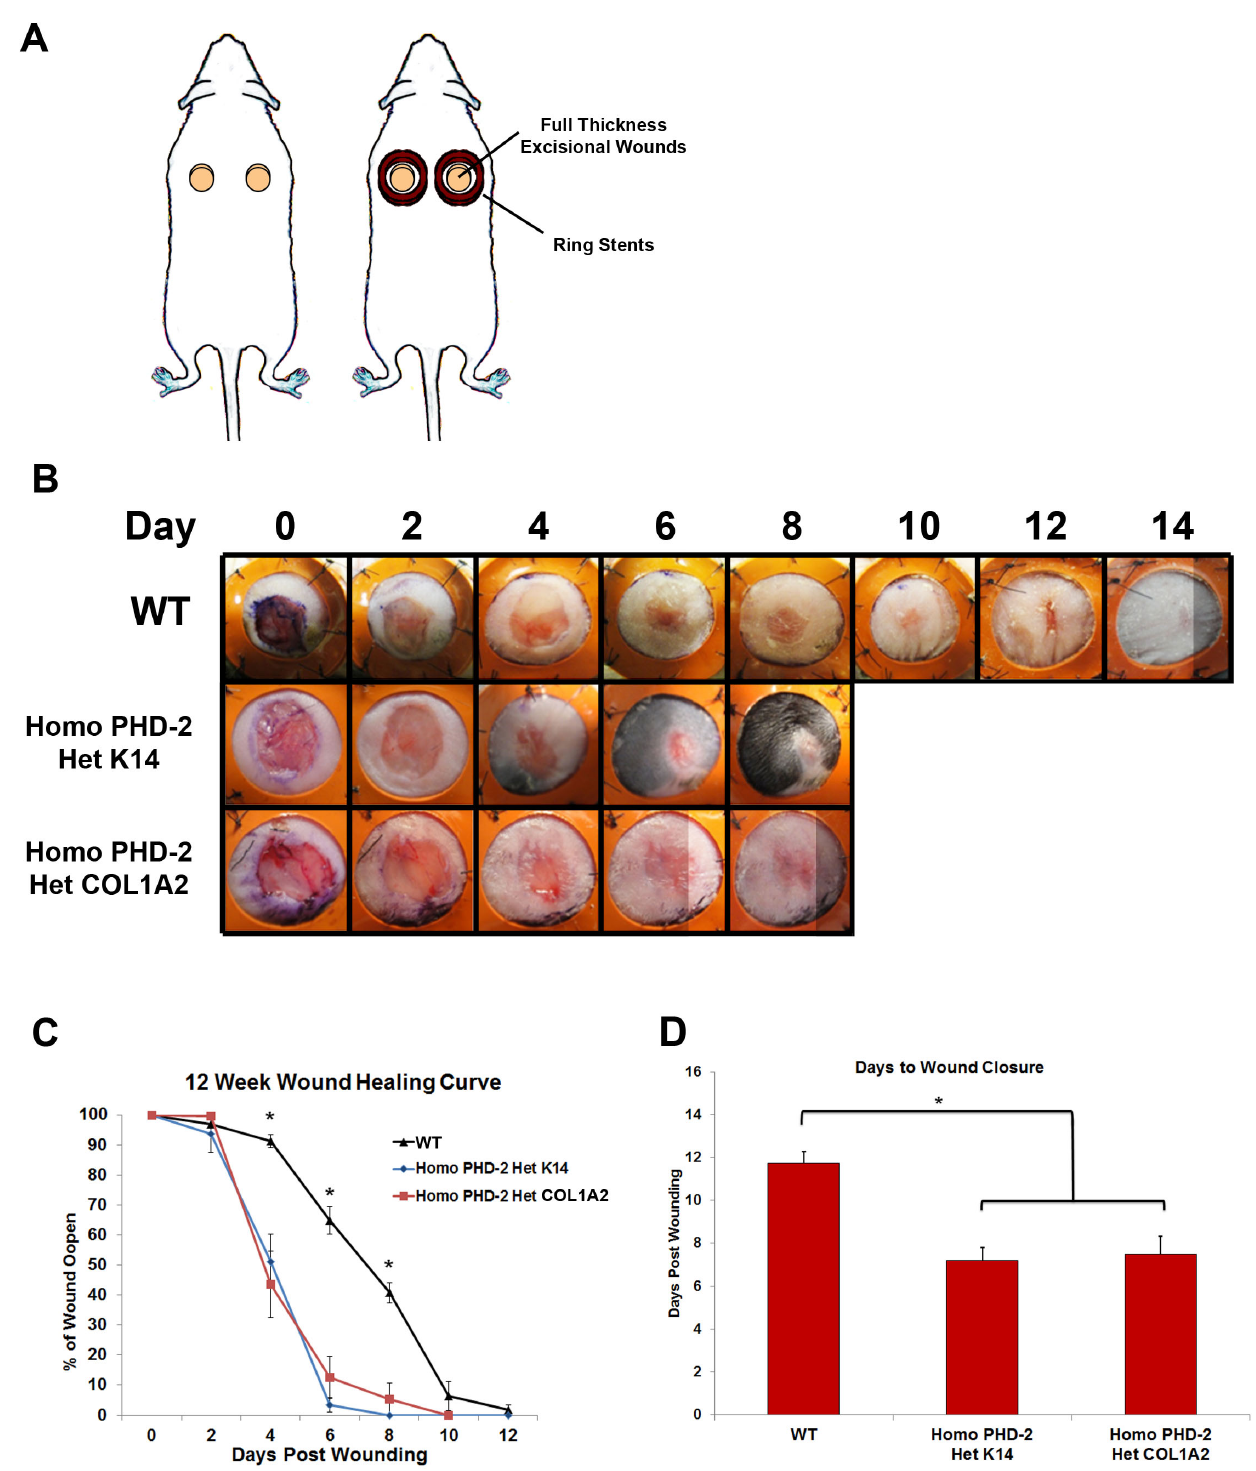
Figure 2. In vivo data from humanized wound healing model. A ) Schematic of stented full-thickness excisional wound model. B ) Representative pictures of wounds from days 0–14 for wild type, heterozygous K14-Cre/homozygous floxed PHD-2, and heterozygous Col1 a 2-Cre-ER/ homozygous floxed PHD-2 mice. C ) Twelve week wound healing curve showing the wound closure rate for wild type, heterozygous K14-Cre/ homozygous floxed PHD-2, and heterozygous Col1 a 2-Cre-ER/homozygous floxed PHD-2 mice with significant differences on days 4, 6, and 8 (*p , 0.05). D ) Graph representing days to wound closure with a significant difference in days to closure between the wild type and the heterozygous K14- Cre/homozygous floxed PHD-2 and heterozygous Col1 a 2-Cre-ER/homozygous floxed PHD-2 mice (*p , 0.05).